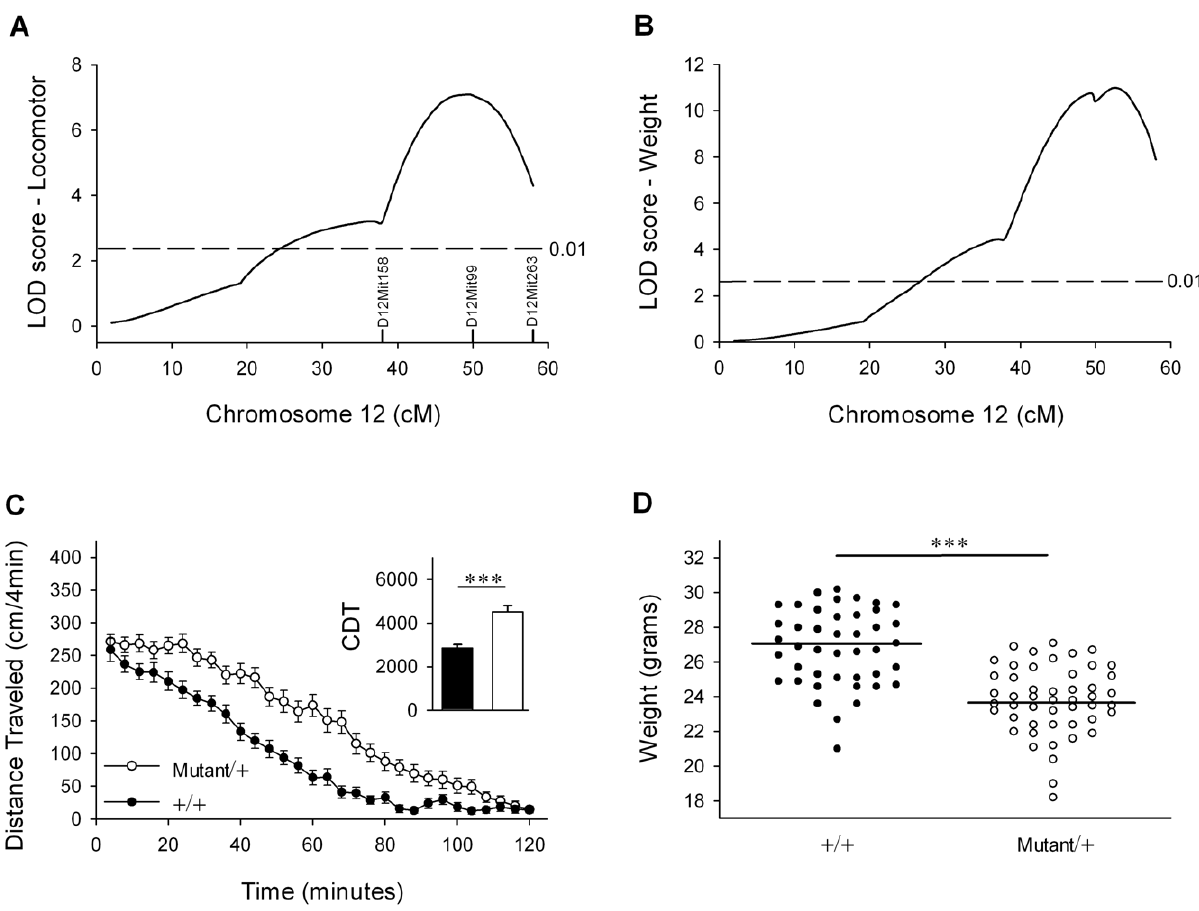
Figure 1. An ENU-induced QTL for locomotor activity and body weight maps to distal mouse chromosome 12. (A) A mutagenized (B6:D2 * ) male 28C4 was backcrossed to C57BL/6J wild-type females and spontaneous locomotor activity of male progeny was monitored for a period of two hours followed by QTL analysis (see reference [23] for details). Significant ( P , 0.01) levels of linkage (dashed black line) were determined by permutation testing [39]. (B) Male B6:D2* 6 B6 progeny were weighed between the age of 8 to 10 weeks and QTL analysis was performed. (C) Haplotype analysis of the mapping population indicates that Mutant/ + mice, which are unambiguous carriers of mutagenized chromosome 12 across the 95% confidence interval (n=50), were modestly hyperactive relative to + / + animals (n=43) across the same confidence interval. Inset: Cumulative distance traveled (CDT) over two hours (in centimeters) is significantly elevated in Mutant/ + males (white bar) versus + / + animals (black bar) N , n=43) and Mutant/ + males ( # , n=49) (*** P % 0.0001, Student’s t-test). (D) Scatterplot of body weight haplotypes of unambiguous + / + males ( across the 95% confidence interval on chromosome 12. Black line indicates average weight of population. + / + males weigh significantly more than Mutant/ + males (*** P % 0.0001, Student’s t-test). See Figure 2 for haplotype structure of Mutant animals.